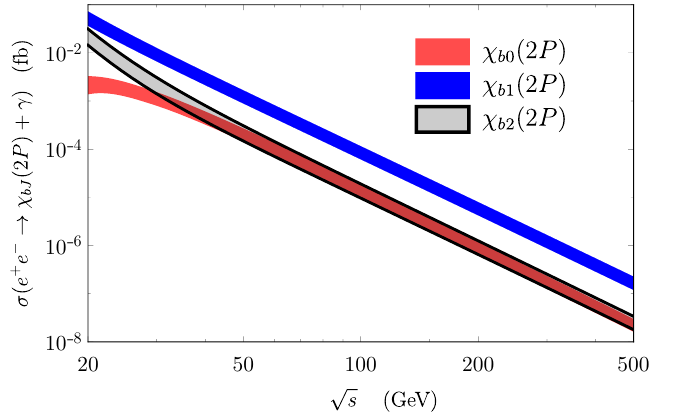
Figure 2 . Predicted cross sections (cid:27) ( e + e (cid:0) ! (cid:31) bJ (1 P ) + (cid:13) ) for J = 0 (red band), J = 1 (blue band), and J = 2 (grey band with black lines).